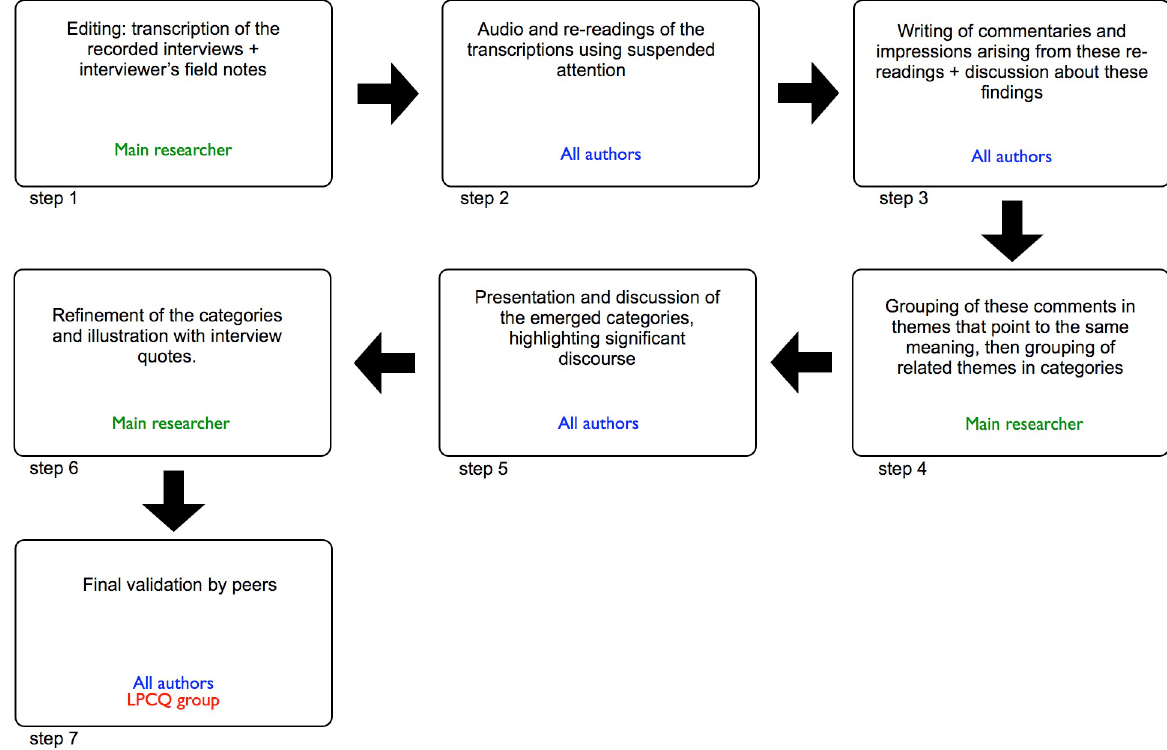
Fig 1. Flow chart of the content analysis. Adapted from Faria-Schutzer et al [20].